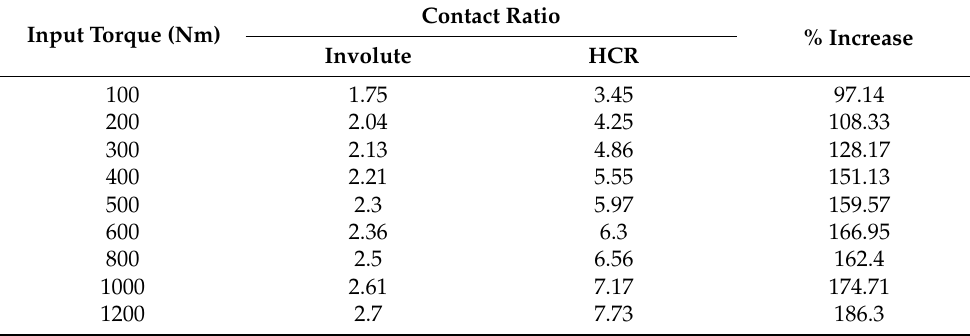
Figure 23. Average contact ratio under different rotational speeds and input torque conditions: ( a ) HCR internal spur gear drive; ( b ) involute internal spur gear drive. Table 5. Percentage increase in contact